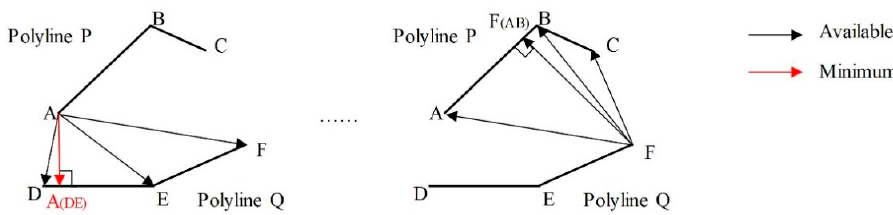
Figure 6. Computation of minimum distance.